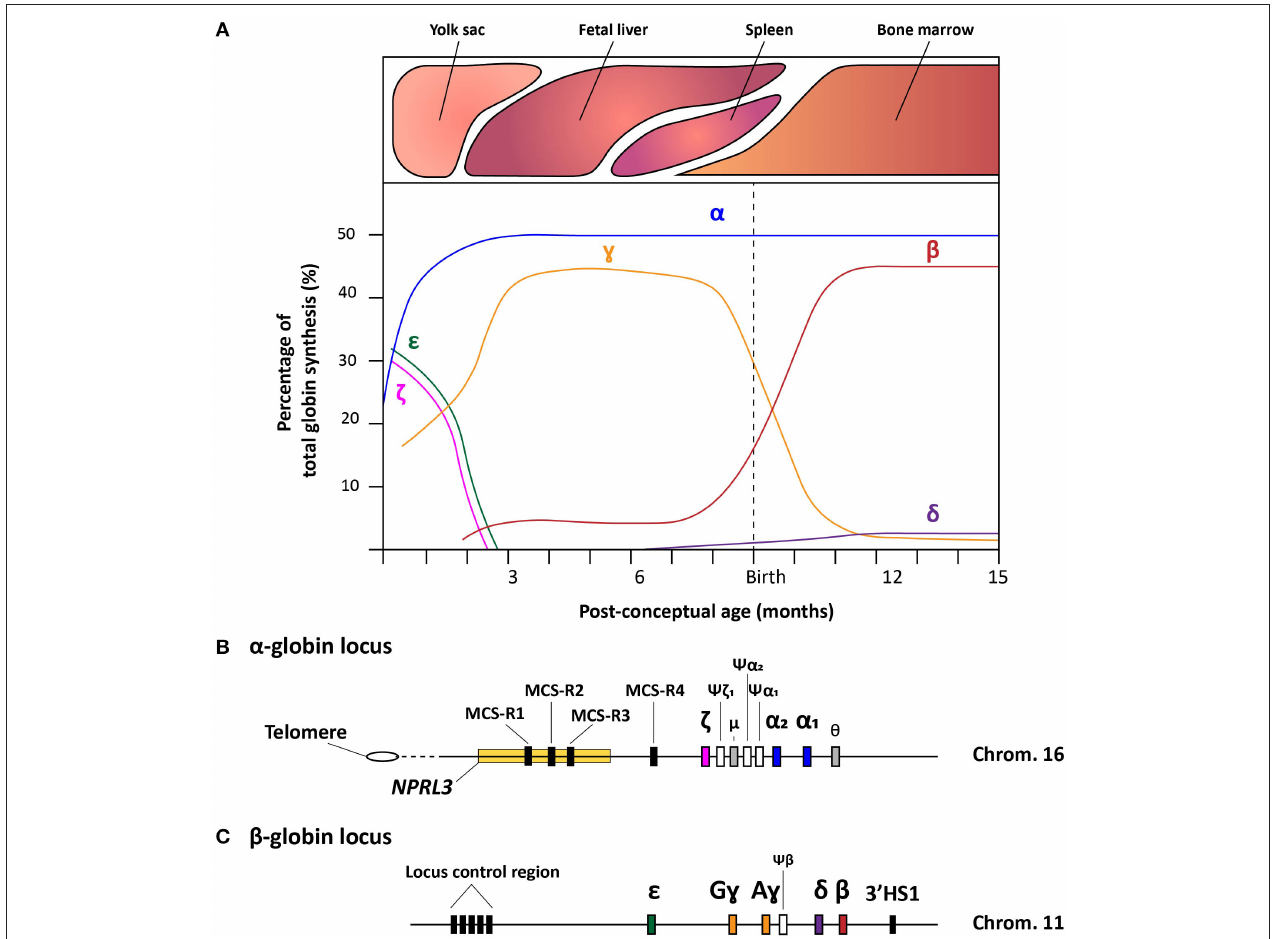
FIGURE 1 | Schematic representation of the hemoglobin switches and the α - and β -globin loci. (A) Schematic representation of the human hemoglobin switches before and after birth displaying each globin chain expression levels as the percentage of total globin synthesis. (B) Detailed schematic representation of the α -globin locus containing the NPRL3 gene in which three of the four multispecies conserved regions (MCS-R1-4) lie. The chronological order of ζ -, α 2 -, and α 1 -globin expression follows the genomic order of the respective α -like globin genes, i.e., HBZ , HBA2, and HBA1 , respectively along the cluster. Furthermore, the three inactive globin pseudogenes ( 9 ) are depicted together with the theta-gene. (C) Schematic representation of the β -globin locus containing the locus control region (LCR), the genes coding functional ε -, G È -, A È -, δ -, and β -globin proteins (i.e., HBE , HBG2 , HBG1 , HBD, and HBB , respectively), the β -pseudogene, also known as HBBP1 , and the 3’HS1 enhancer